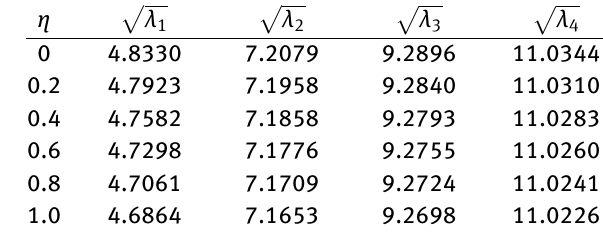
Table 16: Frequency parameter uniform parameter